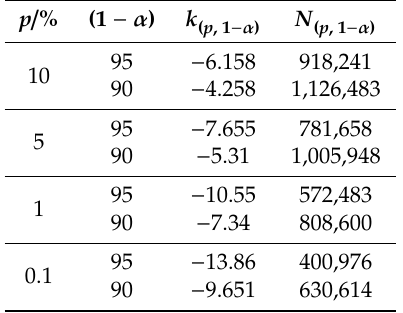
Table 4. Analysis results of the mathematical statistics.